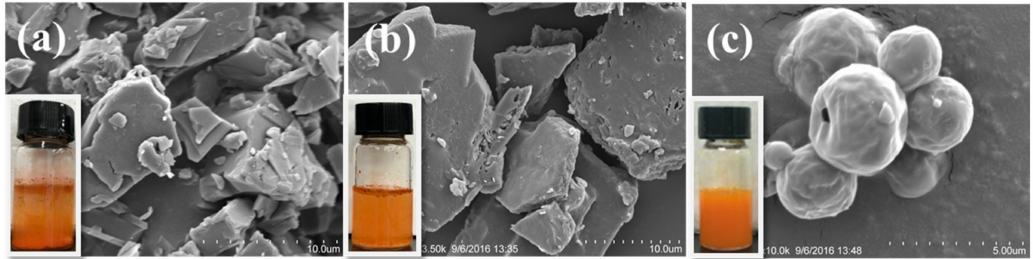
Figure 1. Appearance (dispersed in deionized water at a lutein concentration of 1 mg/mL) and SEM morphology images of native lutein ( a ); lutein-loaded-lecithin microcapsules ( b ) and lutein-loaded NaCas microcapsules ( c